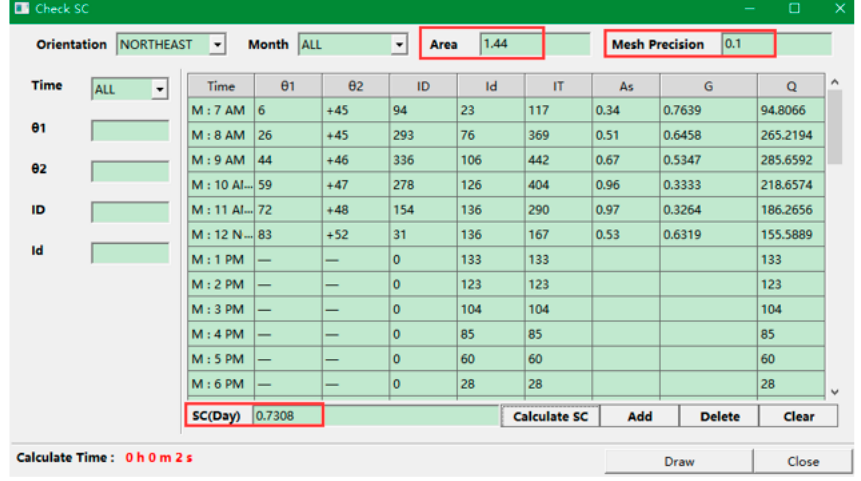
Figure 13. SC2 calculation by using the ETTV Guide table.